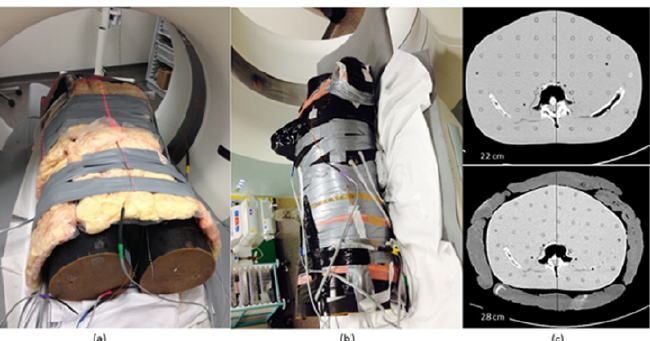
Figure 1. RANDO anthropomorphic phantom ( a ) with and ( b ) without fat layers and MOSFET dosimeters in situ. ( c ) Axial CT image for the phantoms, showing the AP diameter measurements for normal-weighted (22 cm) and obese (28 cm) phantoms.